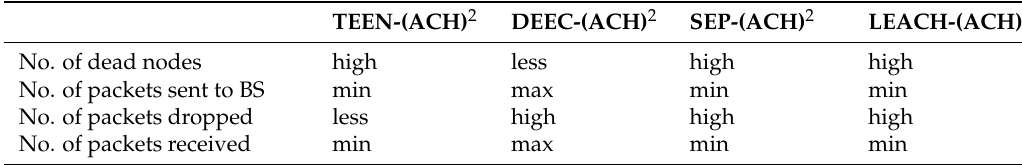
Table 3. Scenario-I: Performance of proposed schemes.